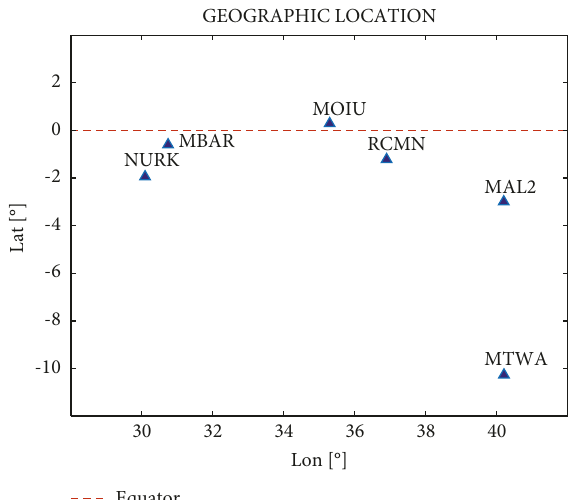
Figure 1: Geographic location of the GNSS receiver stations over East